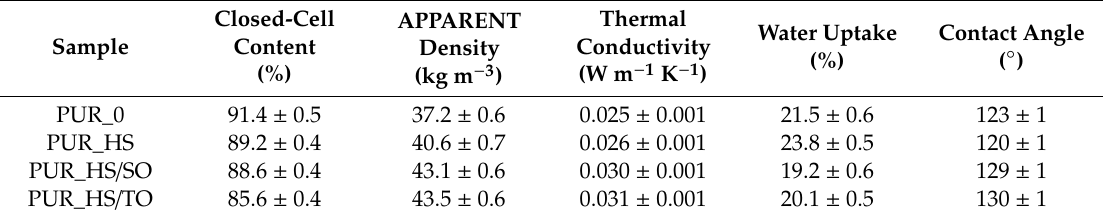
Table 4. Selected properties of PUR foams containing HS